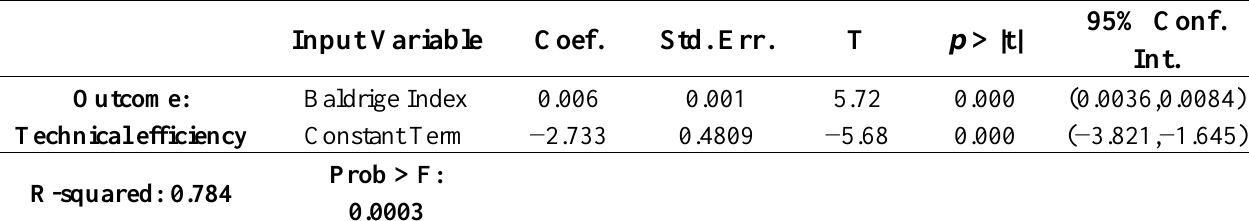
Table 5. Technical efficiency corresponding to liver and kidney transplants.